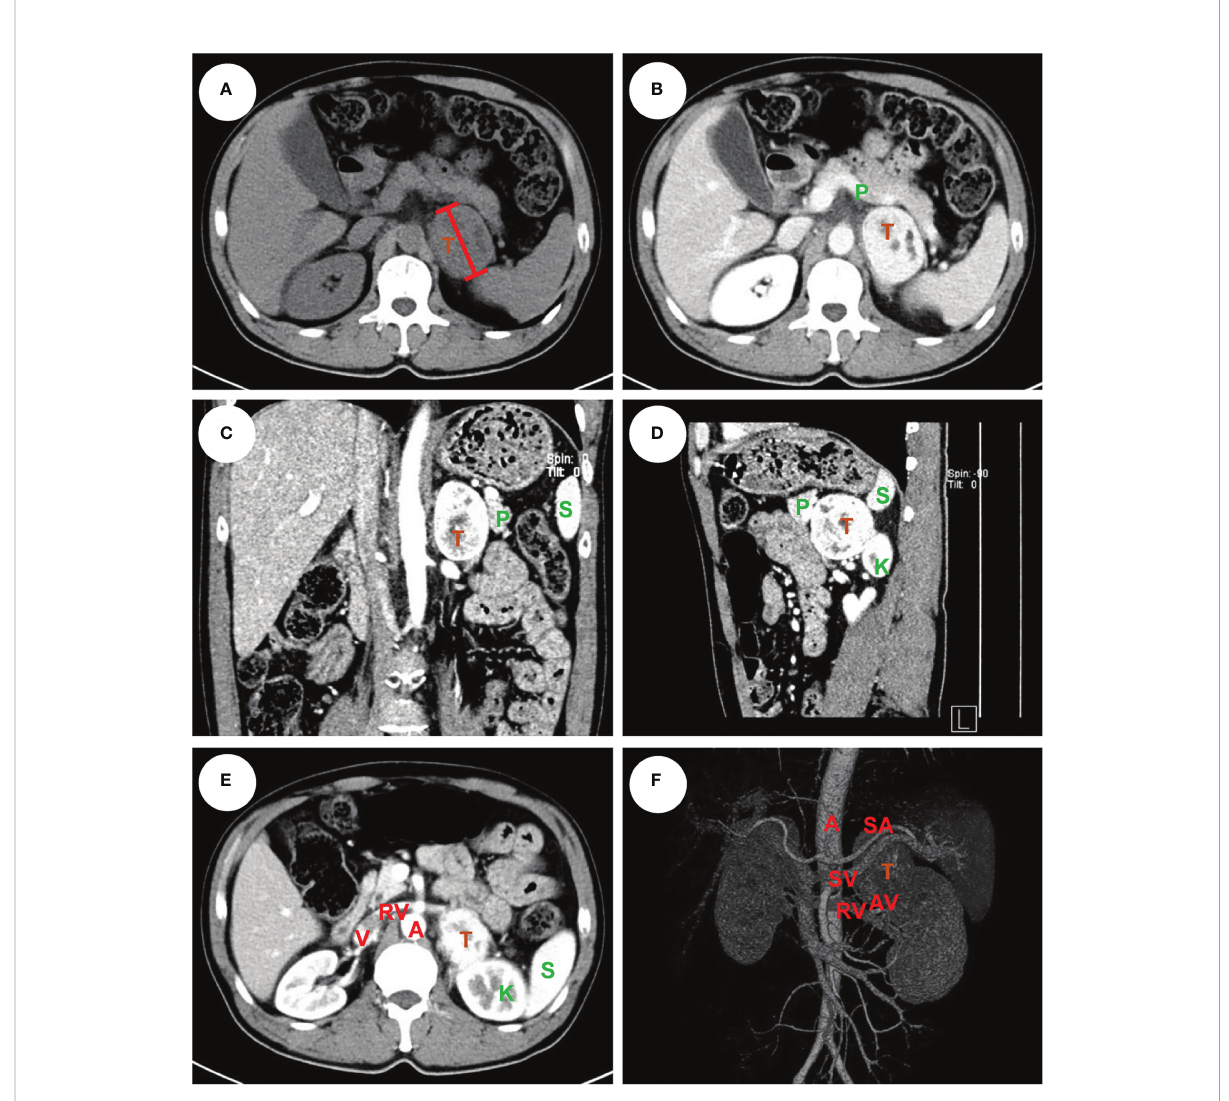
FIGURE 1 An example of left pheochromocytoma. The male patient had a 6 cm pheochromocytoma arising from the left adrenal gland (A) with 110 HU on contrast-enhanced CT (B) . A clear tumor boundary was observed on transverse (B) , coronal (C) and sagittal (D) section which revealed a close relationship between the tumor and ipsilateral kidney, spleen and pancreas. A venous phase section (E) showed the left renal vein travelled to the vena cava underneath the tumor, which was further con fi rmed by a 3-D vessel reconstruction based on arterial-venous phase CT scan demonstrating the relative location of the tumor to surrounding major abdominal vessels (F) . The tumor was removed robotically via retroperitoneal approach. The patient had an ADRENAL score of 2 A + 1 D + 2 R + 2 E + 2 N + 0 A + L L = 9L. T: tumor, P: pancreas, K: kidney, S: spleen, A: aorta, V: (inferior) vena cava, RV: renal vein, SA: splenic artery, SV: splenic vein, AV: adrenal